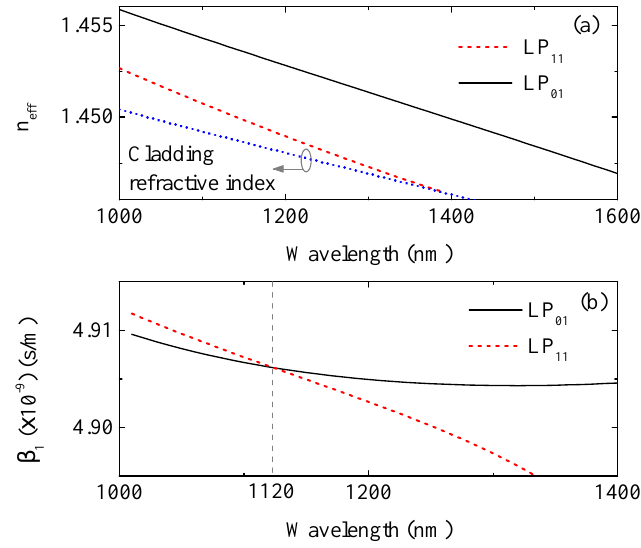
Figure 2. ( a ) Effective index for the LP 01 , LP 11 , and the fiber cladding index as function of the wavelength. ( b ) First derivative of the propagation constant with respect to the angular frequency for the LP 01 and LP 11 as function of the